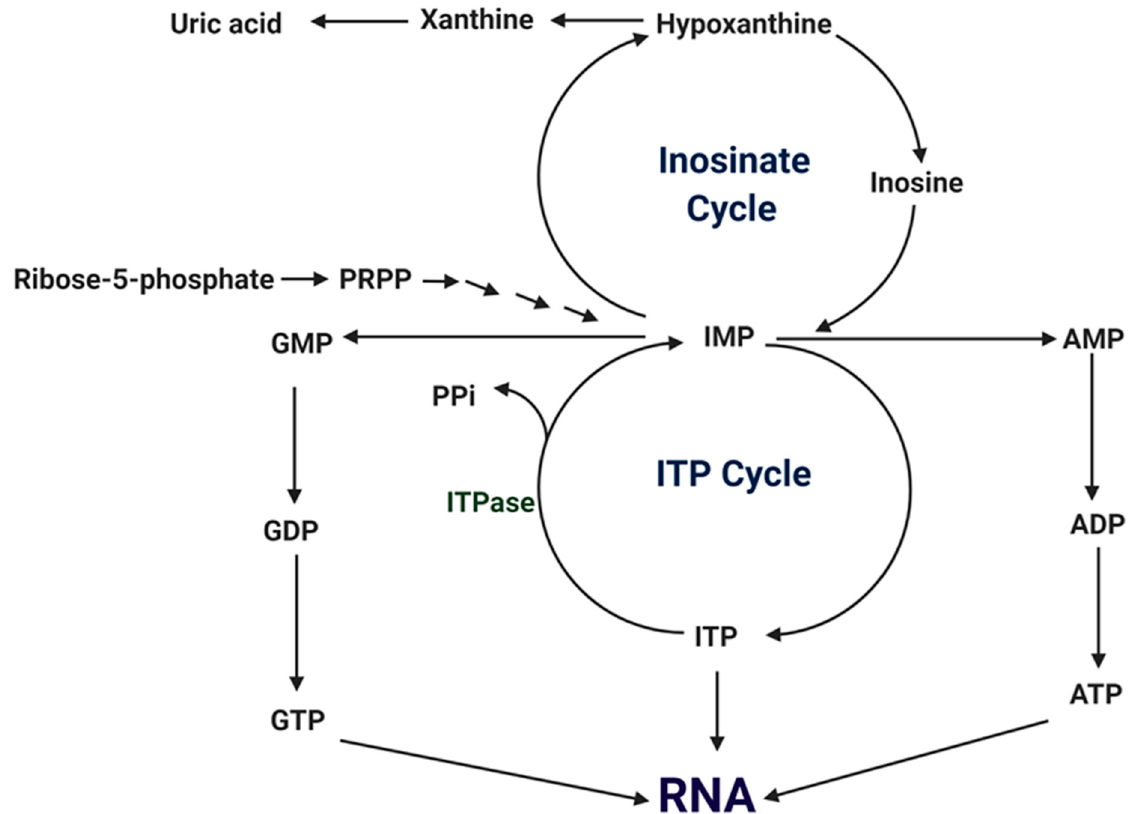
Figure 3. A schematic depiction of ITP cycle.